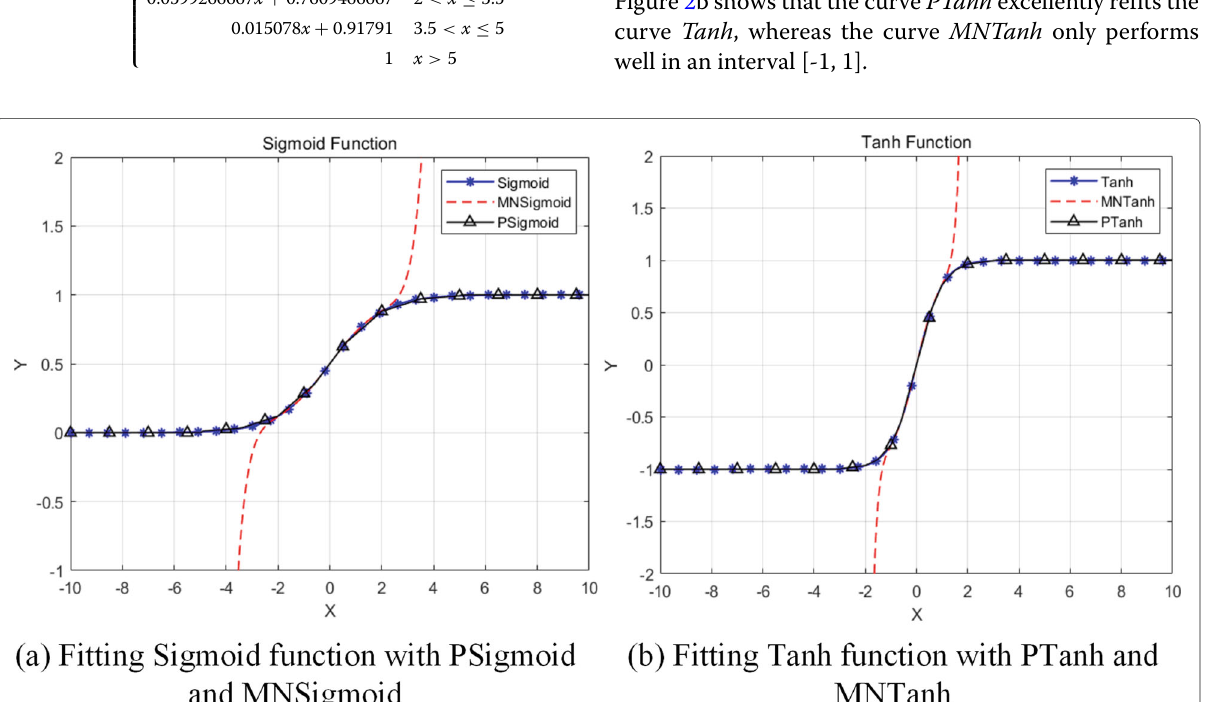
Fig. 2 The piecewise-linear functions PSigmoid and PTanh refit original activation functions Sigmoid and Tanh